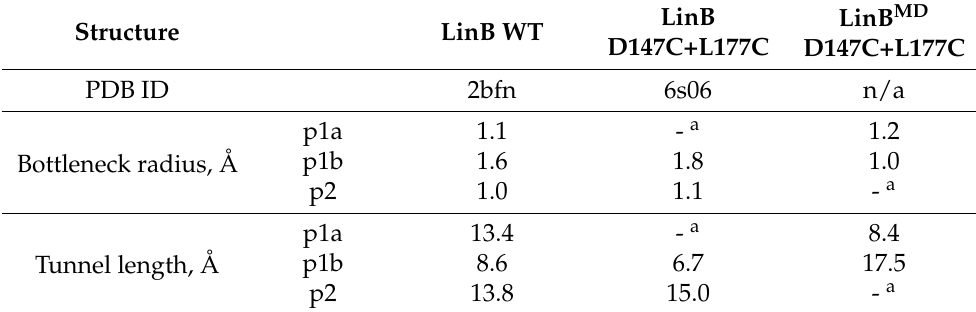
Table 1. Geometry of the access tunnels calculated for different LinB variants using the software CAVER